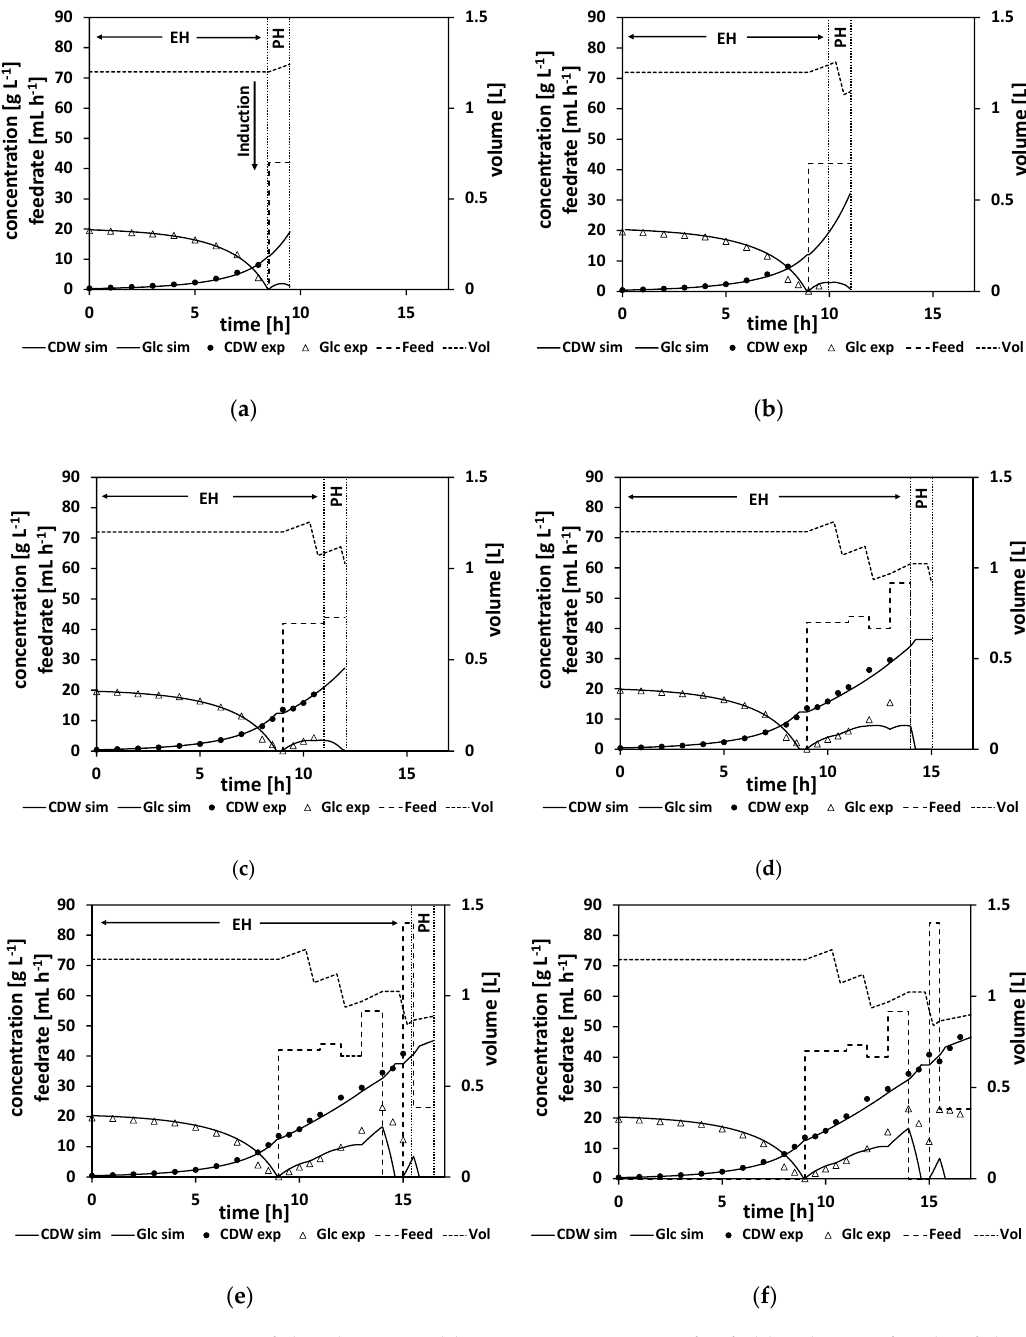
Figure 7. Time course of the glucose and biomass concentration for fed-batch 2. Left side of the vertical dotted lines indicate the estimation horizon (EH): symbols mark samples, the samples were measured as three technical replicates, lines mark the adapted simulated cultivation course (Model B + ), the dashed line shows the calculated feed profile, the dotted line marks show the simulated reactor volume. Between the vertical dotted lines indicating the prediction horizon (PH): the dashed line shows the optimized feed profile, the lines mark the extrapolated cultivation course, the dotted line marks the simulated reactor volume. ( a ) Prediction of the starting time point for feed and the calculation of the optimized first feed rate with extrapolation starting time point τ = 9 h. ( b ) Calculation of the optimized second feed rate at τ = 10 h. ( c ) Calculation of the optimized third feed rate at τ = 11 h. ( d , e ) Calculation of the optimized sixth and seventh feed rate at τ = 14 h and τ = 15 h. ( f ) Finished process. For the parameter estimation results and the feed optimization results, see Tables A8–A10. For model equations, see Table A7 or Table 2.